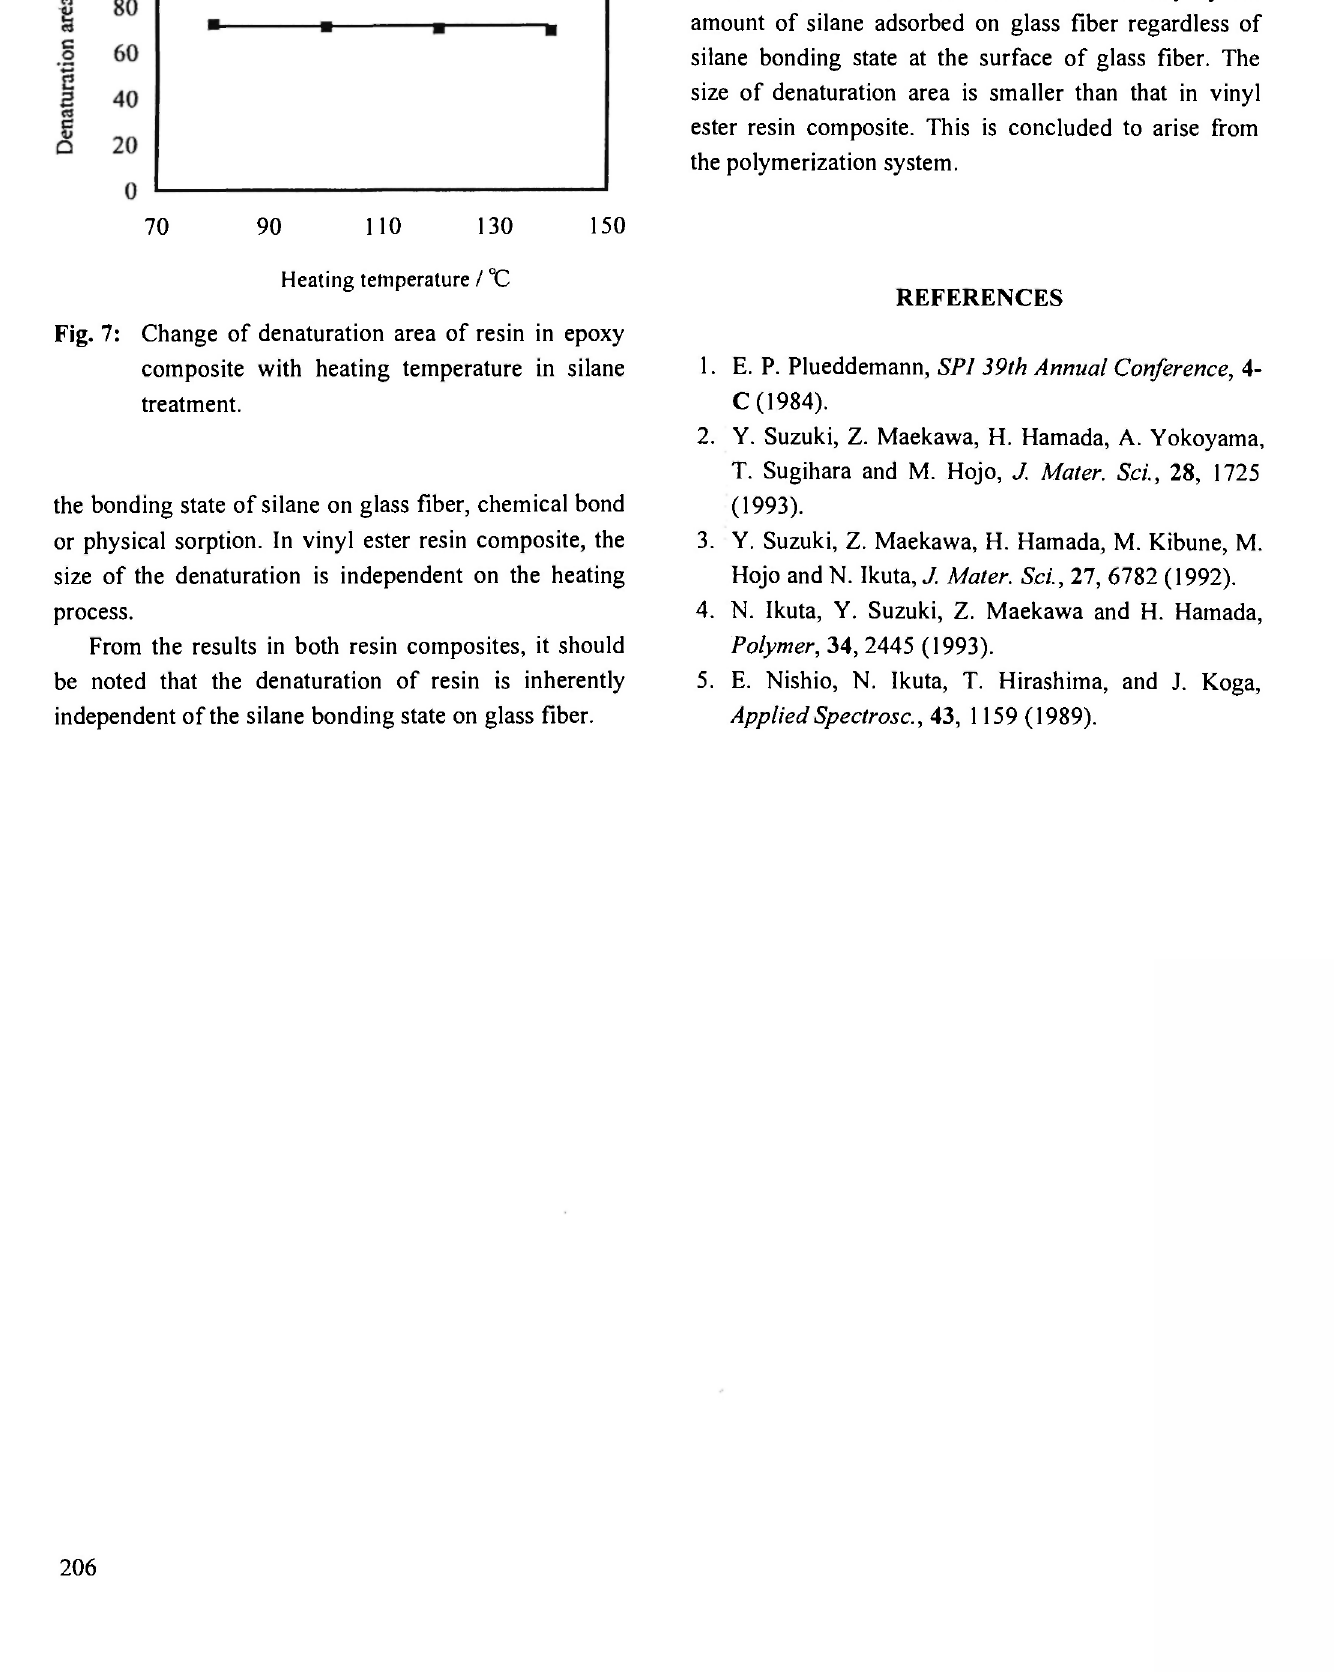
Fig. 7: Change of denaturation area of resin in epoxy composite with heating temperature in silane